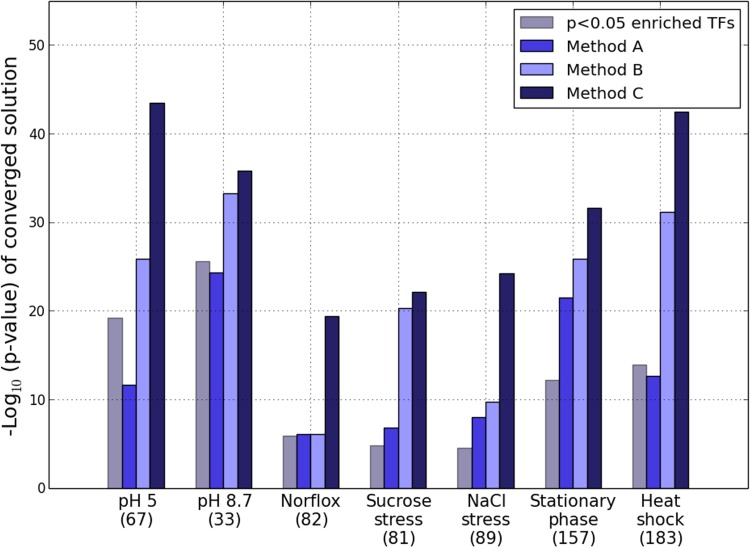
Benchmarking the iterative methods on GEO microarray datasets.Comparison of the iterative methods A-C to identify the maximally discriminative group of TFs, applied to 7 E. coli expression datasets retrieved from GEO. The number in brackets under each label corresponds to the number of TFs in the background network targeting at least one significantly differentially expressed gene each. For sake of comparison we also include the result for the default approach, which has been obtained by merging the target sets for all the TFs showing individual overrepresentation (at p<0.05 level), and estimating the collective p-value for this union.